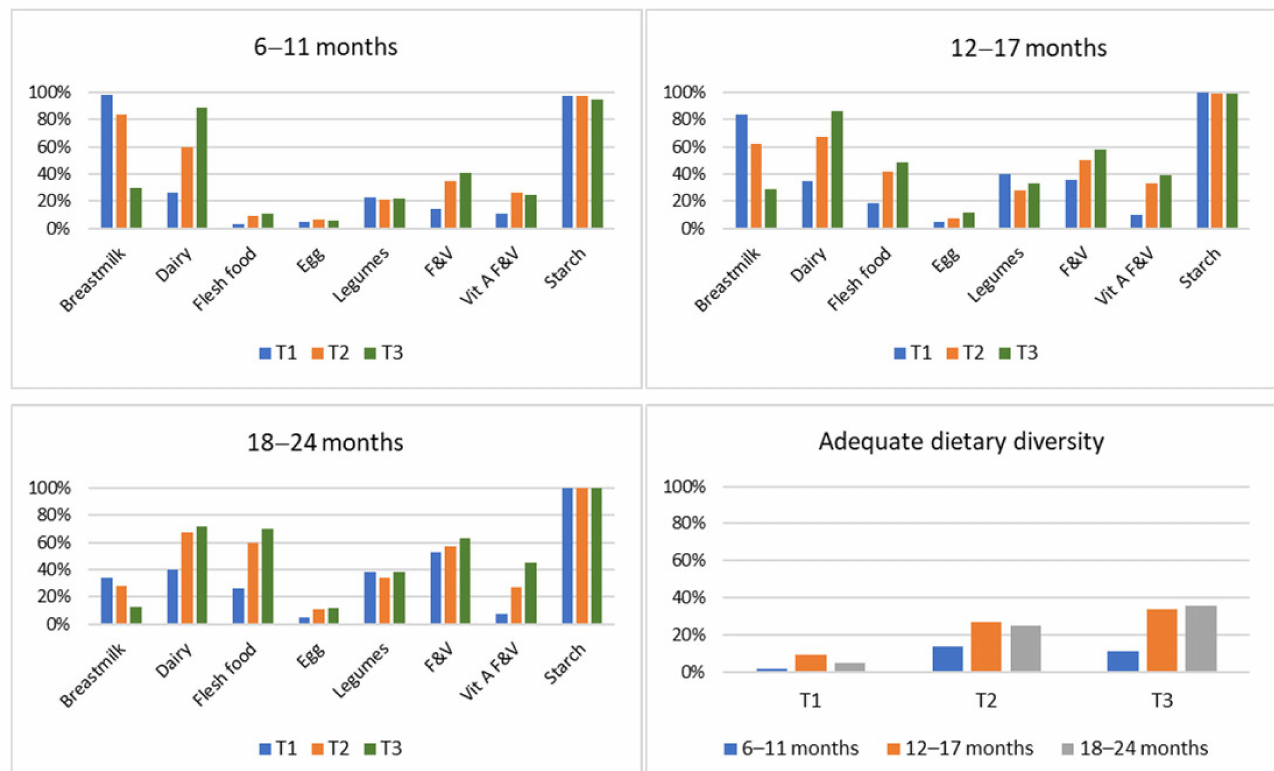
Figure 4. Food groups included for each of the respective retail cost tertiles and adequate dietary